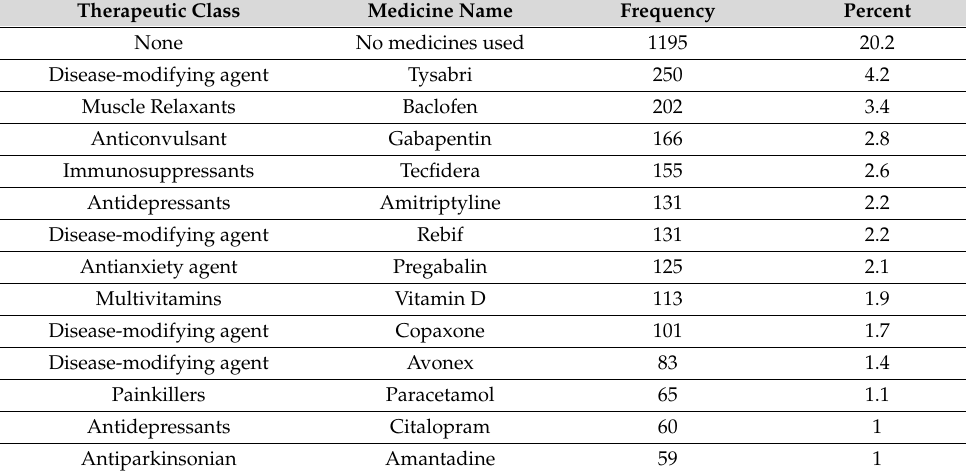
Table 7. Most frequent medicine names used by people with MS in the UKMS register over a two-month period of